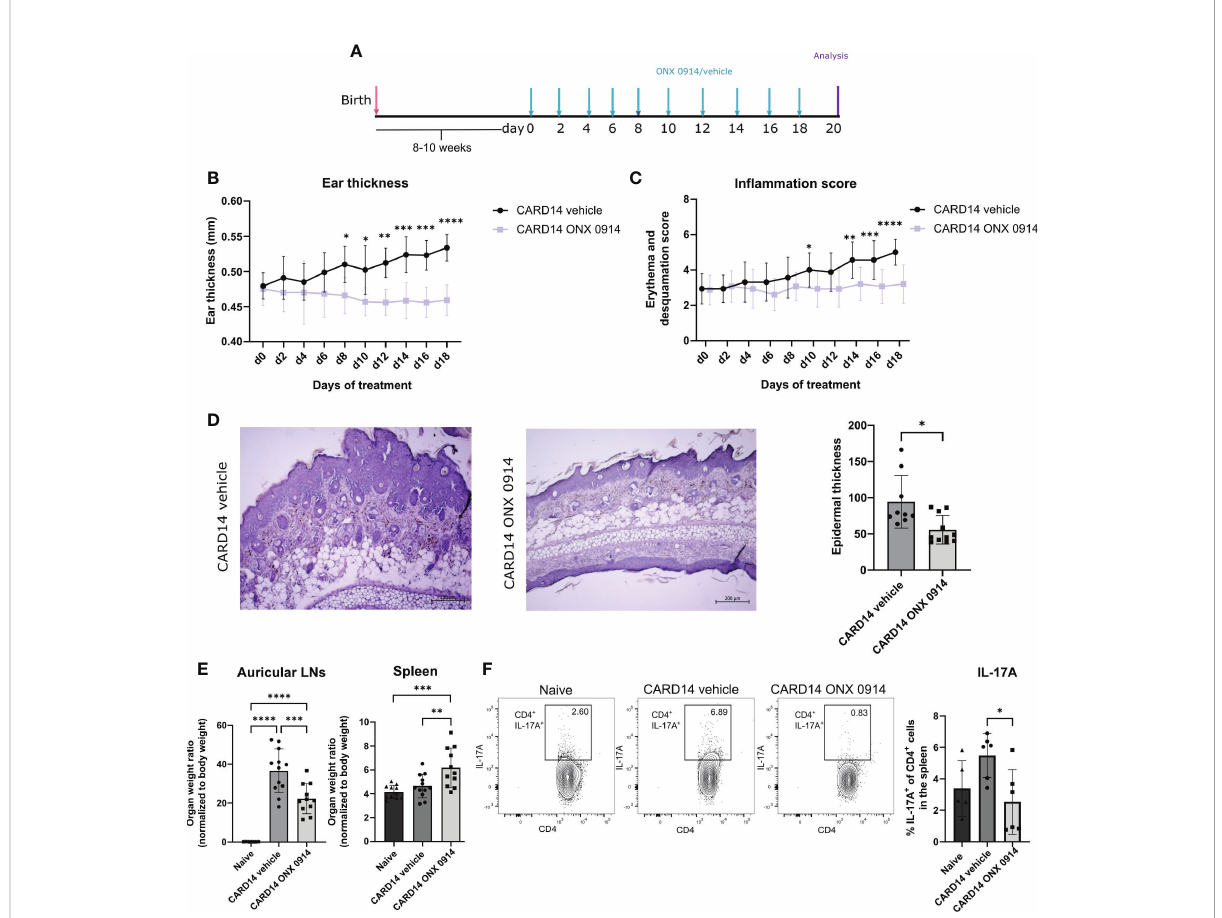
FIGURE 1 Immunoproteasome inhibition attenuated the psoriasis-like lesions in Card14 D E138 +/- mice: 8-10 weeks old Card14 D E138 +/- mice were treated on alternate days with 10 mg/kg ONX 0914 or vehicle for 20 days. (A) Experimental setup. (B) Ear thickness was measured with a thickness gauge. On the g -axis, the ear thickness in mm is depicted. Data (vehicle n = 7, ONX 0914 n = 6) was pooled from two independent experiments and analyzed by a two-way ANOVA followed by a S ̌ ida ́ k test. (C) The in fl ammation score was measured visually on alternate days and results from the sum of the eczema and scaling scores, which are shown on the g -axis. Data (vehicle n = 16, ONX 0914 n = 15) was pooled from fi ve independent experiments and analyzed by a two-way ANOVA followed by a S ̌ ida ́ k test. (D) Representative hematoxylin-eosin-stained sections from the ear of Card14 D E138 +/- after 20 days of treatment with ONX 0914 or vehicle. The epidermal thickness was measured in ImageJ and normalized to the epidermal area, which is depicted on the g -axis. Data (vehicle n = 9, ONX 0914 n = 11) was pooled from three independent experiments and analyzed by a Mann-Whitney test. The scale bar is 200 m m. (E) The auricular lymph nodes and the spleens were harvested after 20 days of ONX 0914 treatment and weighed. On the g -axis, the organ-to-body weight ratio is depicted. Naïve mice were used as controls. Data (naïve n = 11, vehicle n = 12, ONX 0914 n = 11) was pooled from three independent experiments and analyzed by one-way ANOVA followed by a Tukey´s test. (F) . The splenocytes of mice treated with ONX 0914 or vehicle were collected and stimulated with PMA, ionomycin and BFA for 4 hours at 37°C. Then, an intracellular cytokine staining for IL-17A was performed. On the g -axis the frequency of IL-17A + cells in the spleen is depicted (left panel). The gating strategy is depicted in Supplementary Figure 3A and includes doublet and dead cell exclusion. The IL-17A + cells are pregated on CD45 + CD4 + cells. Gating was performed using a Fluorescence minus one (FMO) control. Representative dot plots are depicted on the right panels. Data (n = 6) was pooled from two separate experiments and analyzed by one-way ANOVA followed by a Tukey´s test. All values represent mean ± SD. * p < 0.05, ** p <0.01, *** p < 0.001, and **** p <